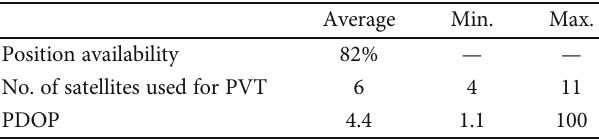
Table 4: GPS receiver